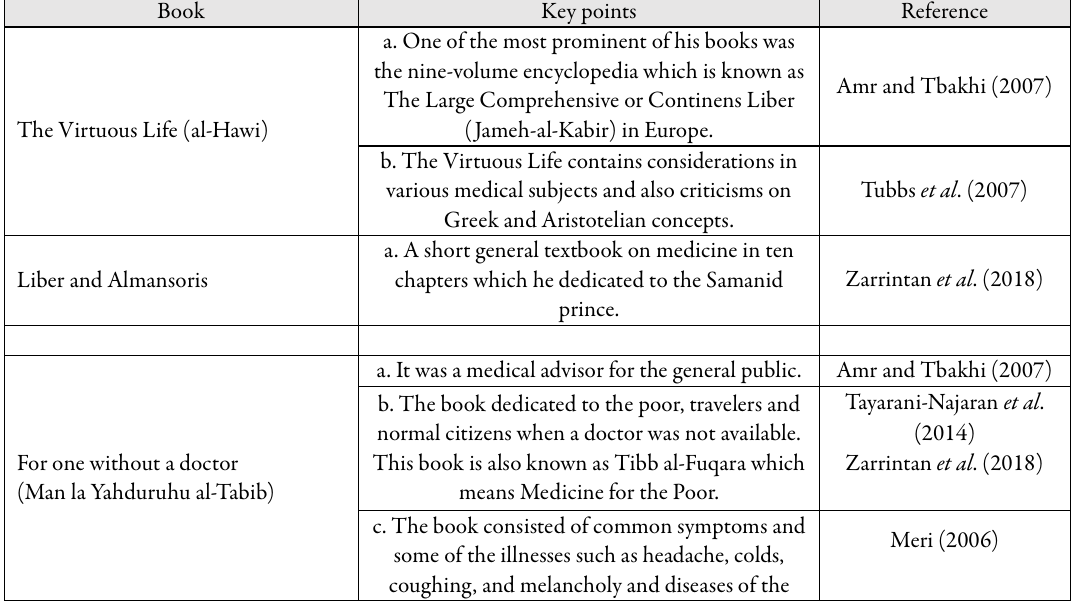
Table 14. The most important books and articles of Rhazes on